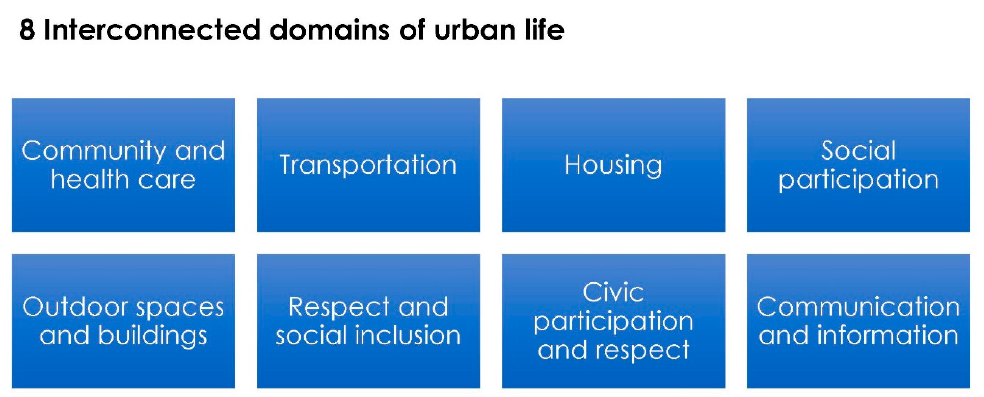
Figure 1. The eight interconnected domains of the Age-Friendly Communities framework [35].